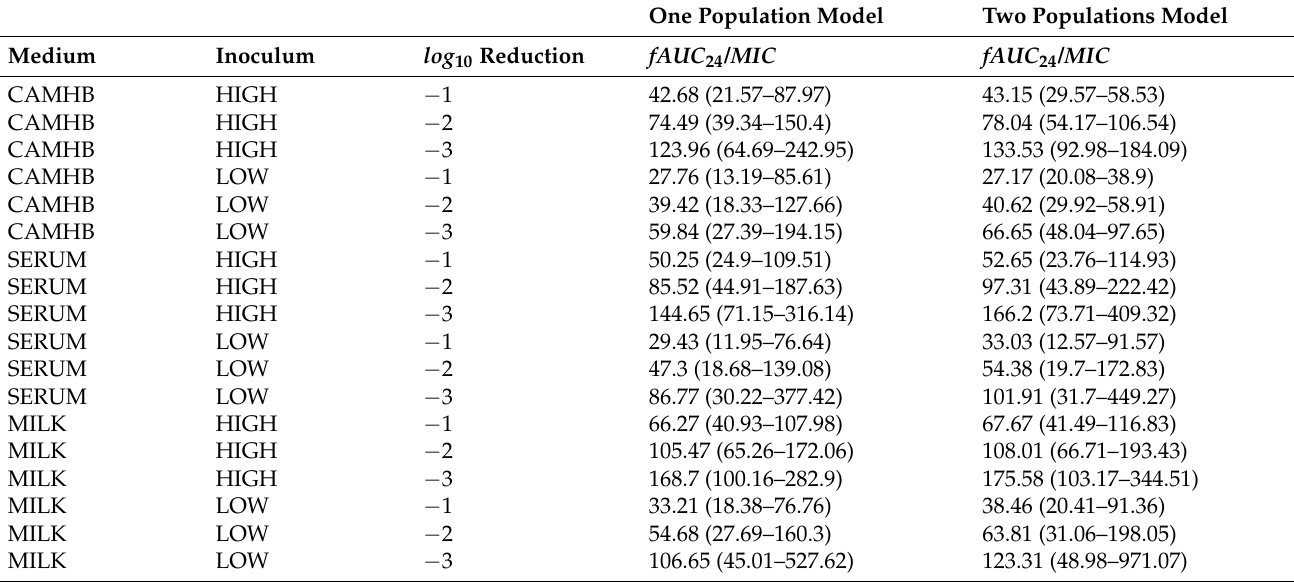
Table 6. PK/PD breakpoint expressed as fAUC 24 / MIC necessary to achieve a log 10 reduction of − 1, − 2 and − 3 from the initial populations. Data are presented as median with 5th and 95th percentiles from one and two population bacterial models,